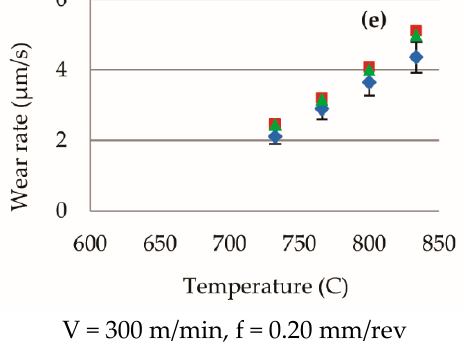
Figure 17. Predicted wear rate according to the modified Usui model in comparison with experiment.